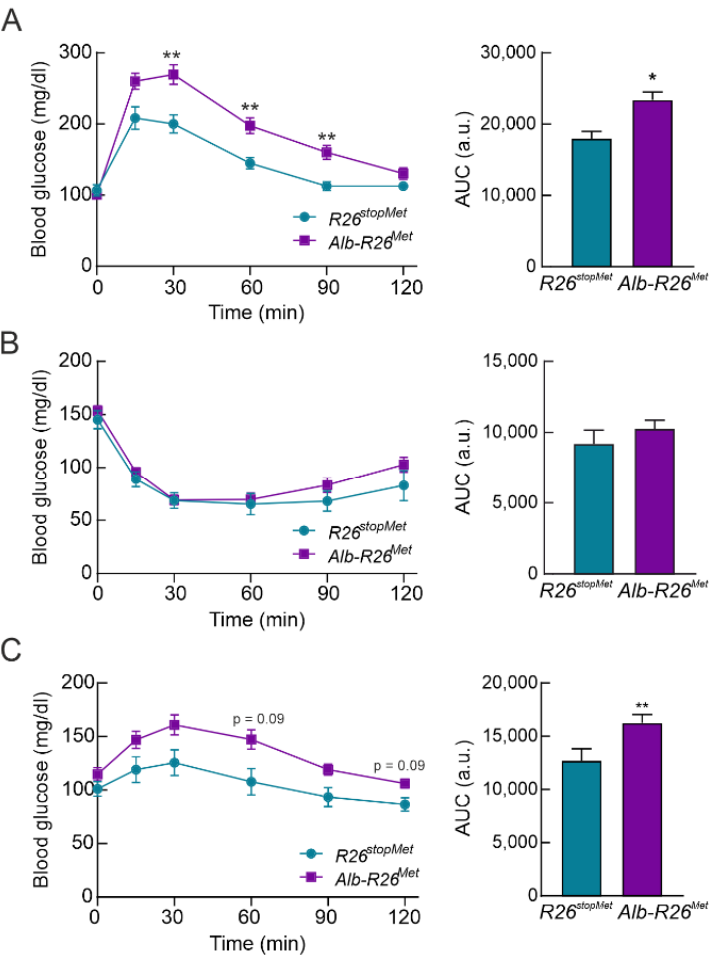
Figure 3. Enhanced MET levels in hepatocytes impairs glucose homeostasis. ( A ) Glucose tolerance test (GTT) in R26 stopMet and Alb-R26 Met mice ( n = 11 and 38 mice per group, respectively). Graph depicts the area under the curve (AUC) from GTT. ( B ) Insulin tolerance test (ITT) in R26 stopMet and Alb- R26 Met mice ( n = 10 and 39 mice per group, respectively). Graph depicts AUC from ITT. ( C ) Pyruvate tolerance test (PTT) in R26 stopMet and Alb-R26 Met mice ( n = 14 and 35 mice per group, respectively). Graph depicts AUC from PTT. ( A – C ) Values correspond to mean ± SEM. For time-course studies, statistical analysis was performed by a two-way repeated measures (RM) ANOVA followed by a Bonferroni post hoc test. For AUC, statistical analysis was performed according a Student’s t test. * p < 0.05, ** p < 0.01 vs. R26 stopMet mice.